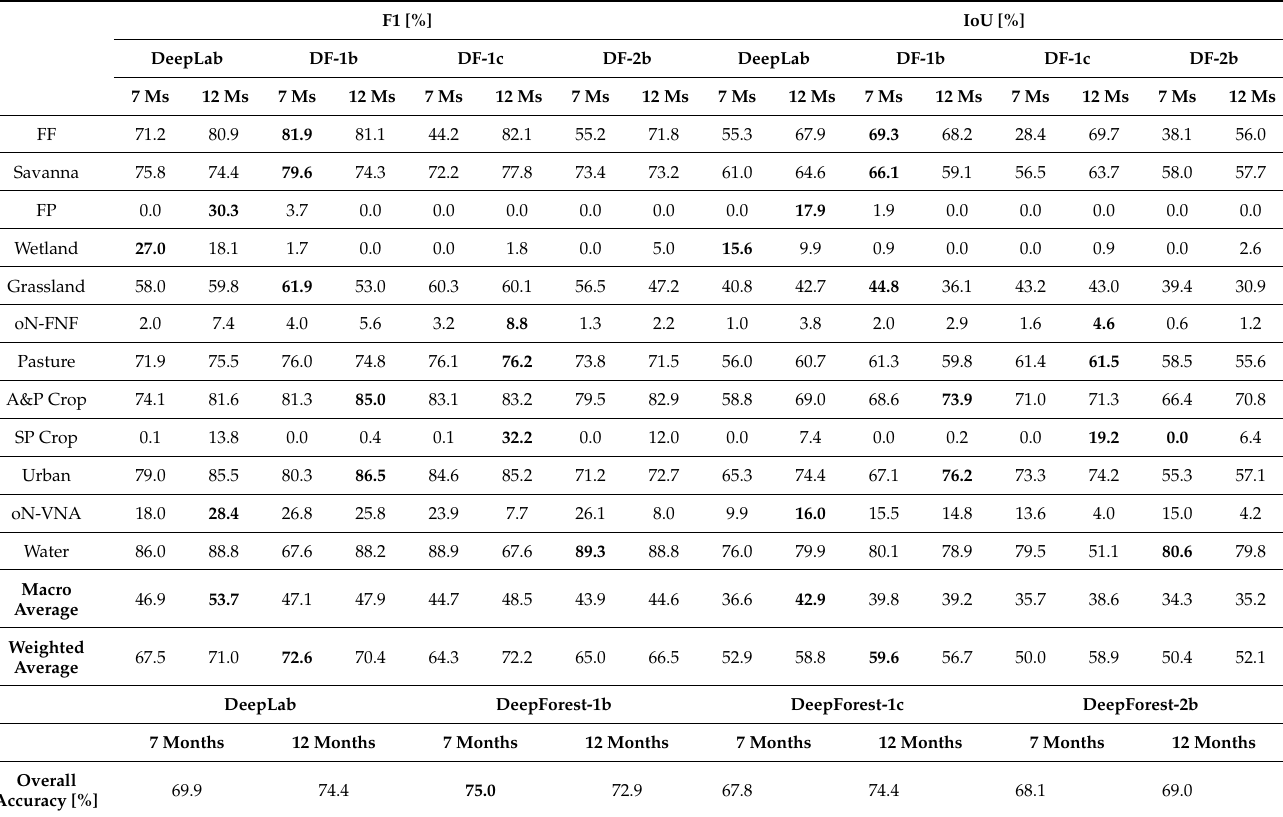
Table 5. Test metrics comparison of DeepForest-1 and DeepLab with different time-series lengths